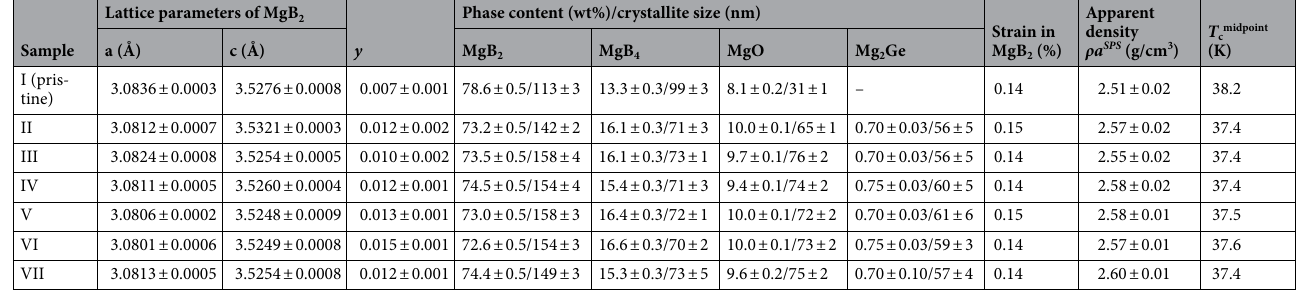
Table 1. Samples, lattice parameters a and c , amount y of carbon substituting boron in MgB 2 (Mg(B 1− y C y ) 2 ), phase content, crystallite size, residual strain, apparent density, and midpoint critical temperature T cmidpoint